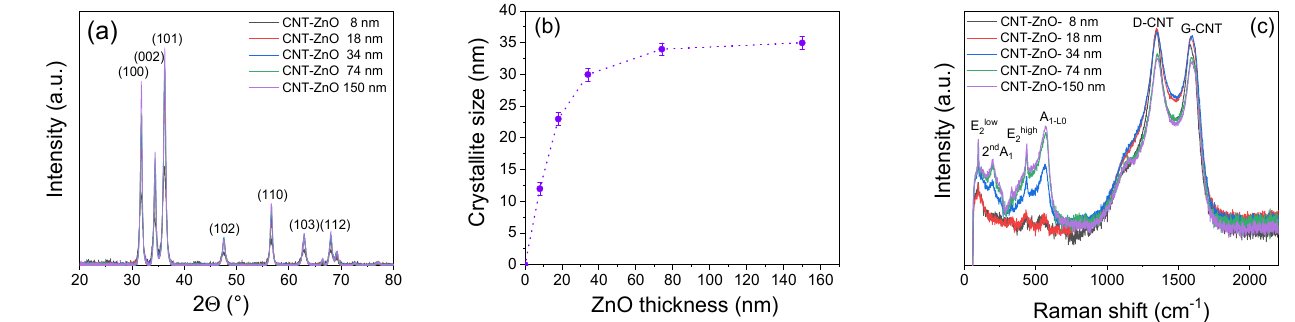
Figure 3. XRD spectra of the CNT-ZnO coatings on silicon ( a ) with the extracted crystallite size ( b ); and their respective Raman spectra ( c ).